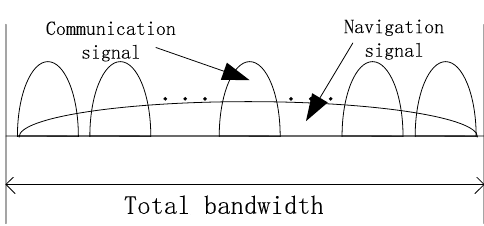
Figure 1. The power spectral density (PSD) of signal generated by method 1.